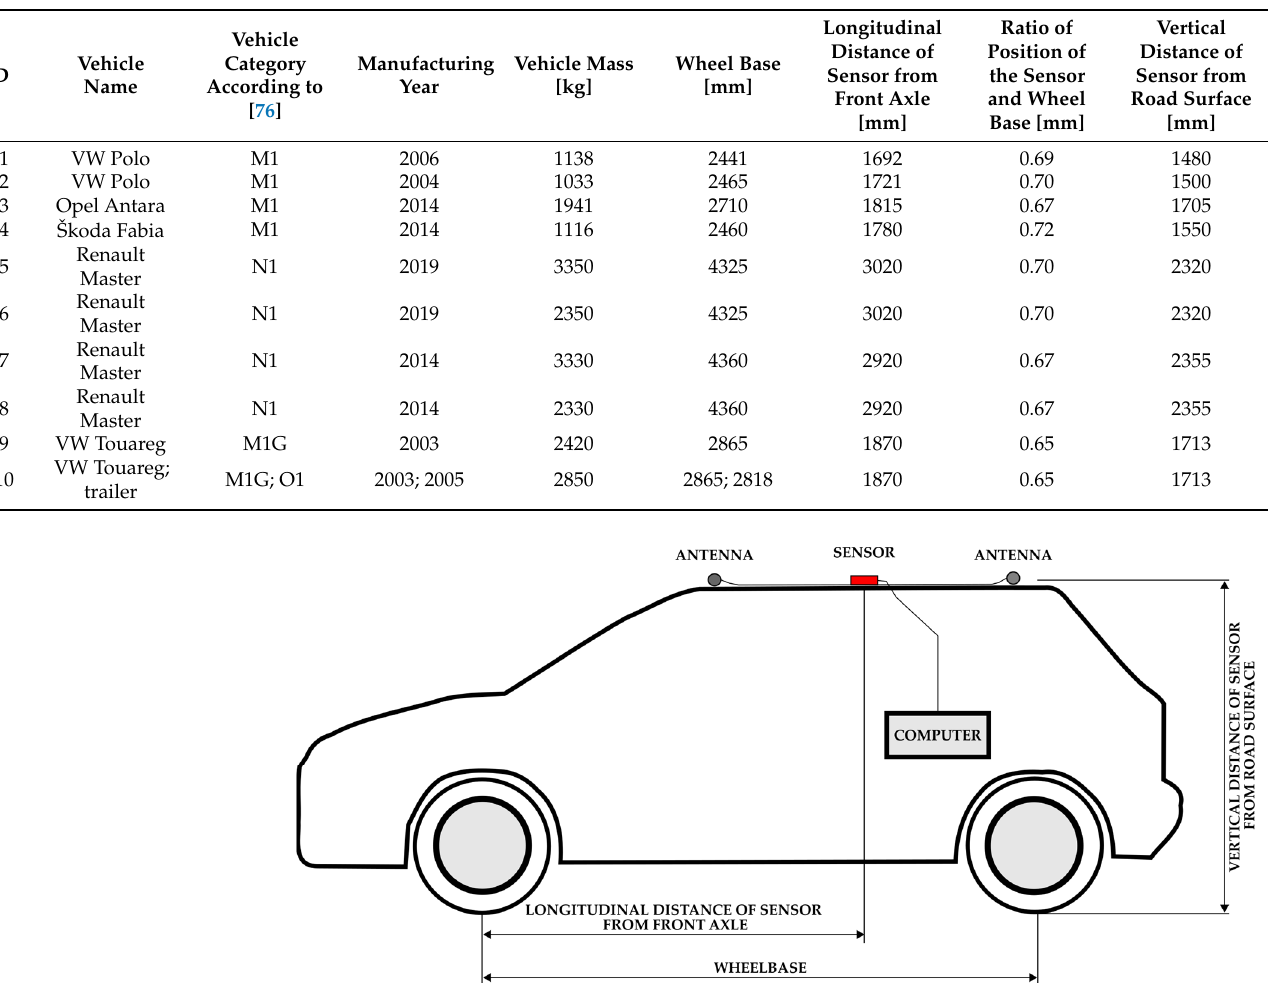
Figure 6. Scheme of test setup installation. Table 3. Selected parameters of vehicles used in tests.